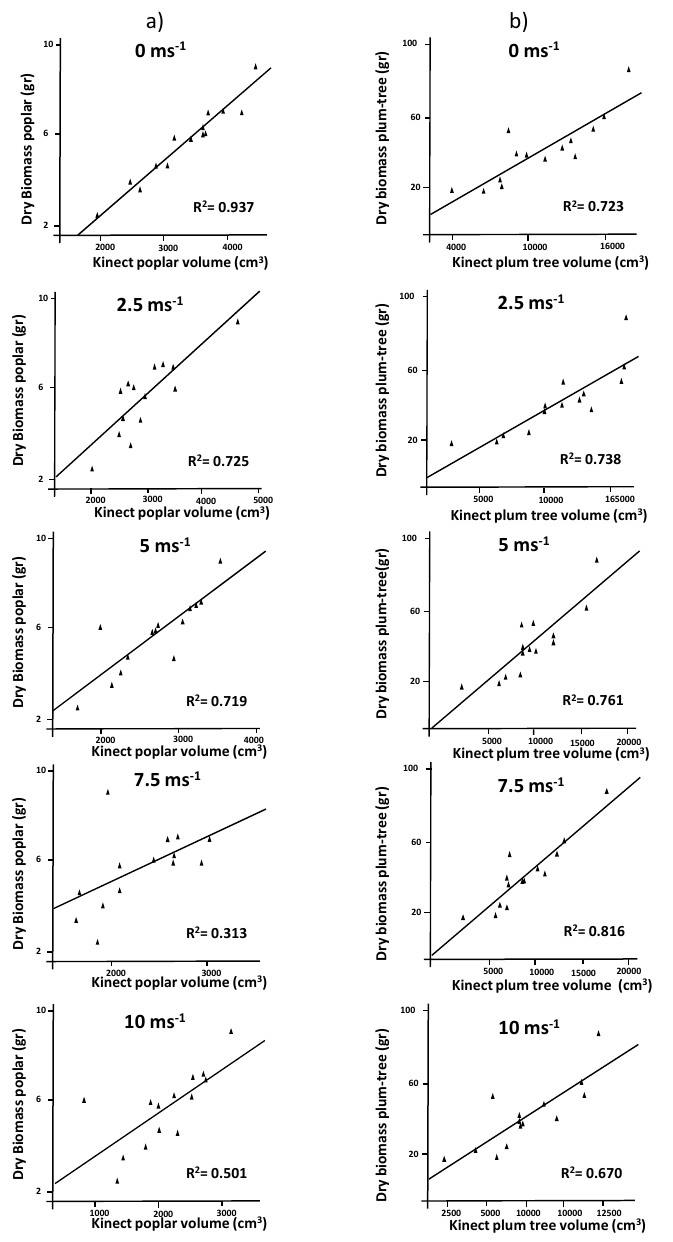
Figure 6. Regression analysis comparing dry biomass (g) vs. tree volume for ( a ) poplar trees and ( b ) plum trees at wind speeds ranging from 0 to 10 m·s − 1 .